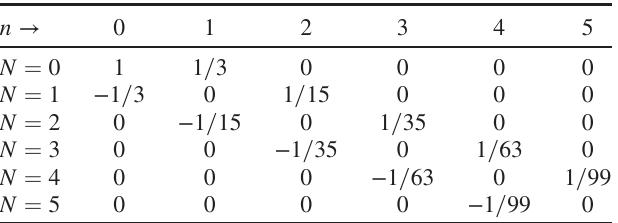
TABLE I. Fragment of the matrix R N;n . Its general form is given by Eqs. (13) and (16).